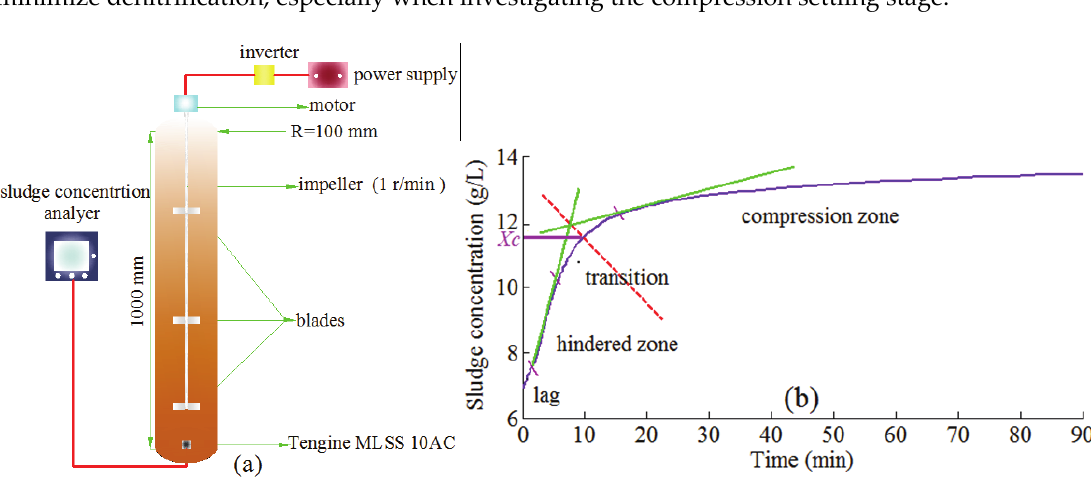
Figure 1. ( a ) Device used for the sludge thickening experiment (R is the radius of the settling column.); and ( b ) The activated sludge thickening